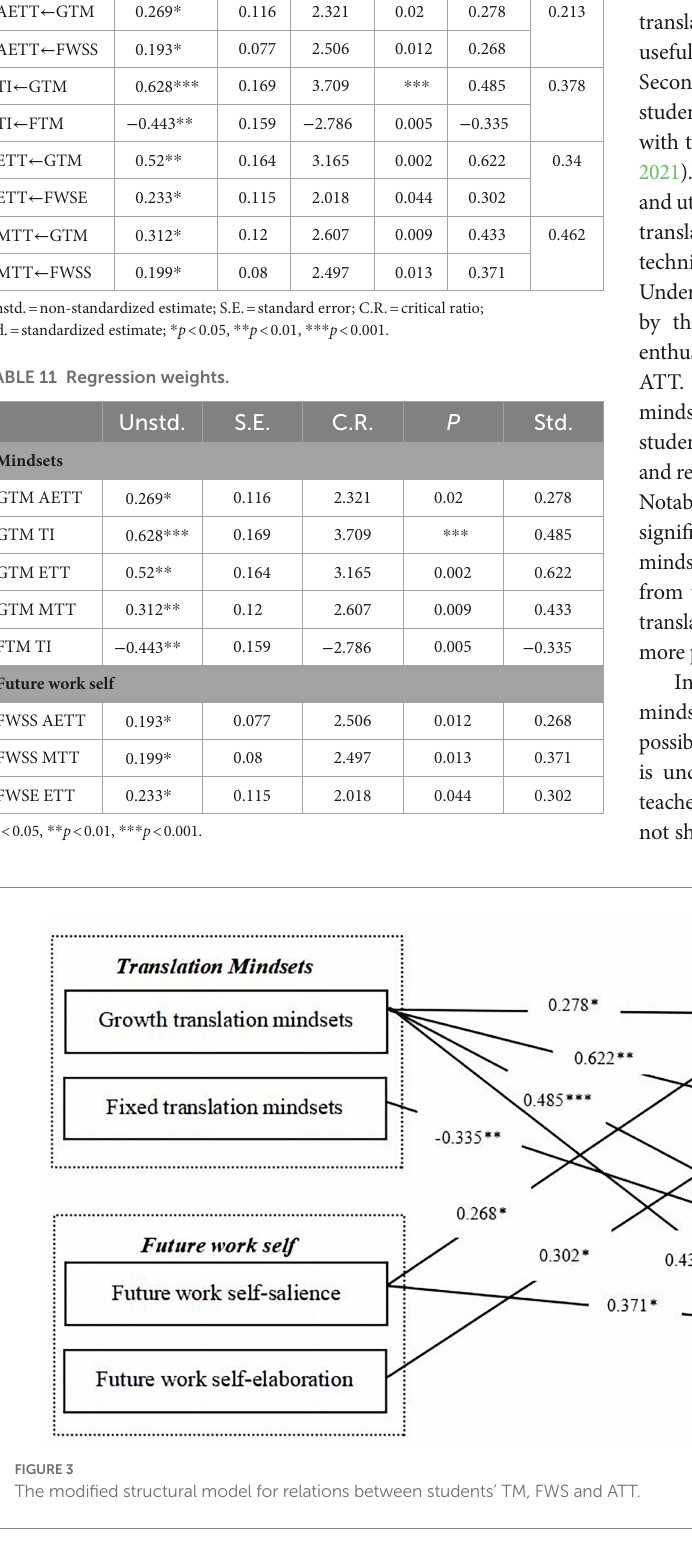
translation mindsets positively associate with students’ attitudes towards the effectiveness of translation technology, teacher influence, exhibition to translation technology, and mindfulness about translation technology. TABLE 10 Parameter estimates of path analysis. Causal Unstd. path